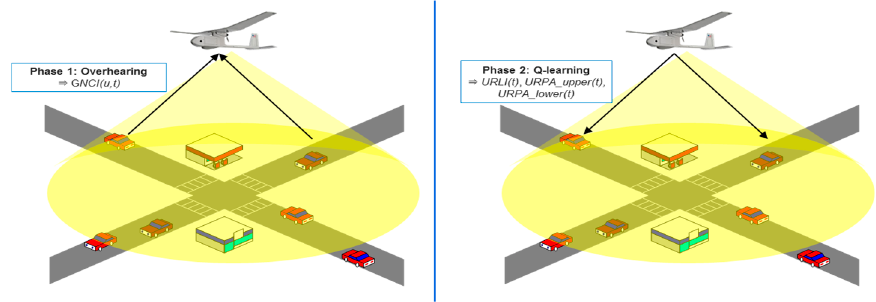
Figure 3. Two phases of Q-LBR.